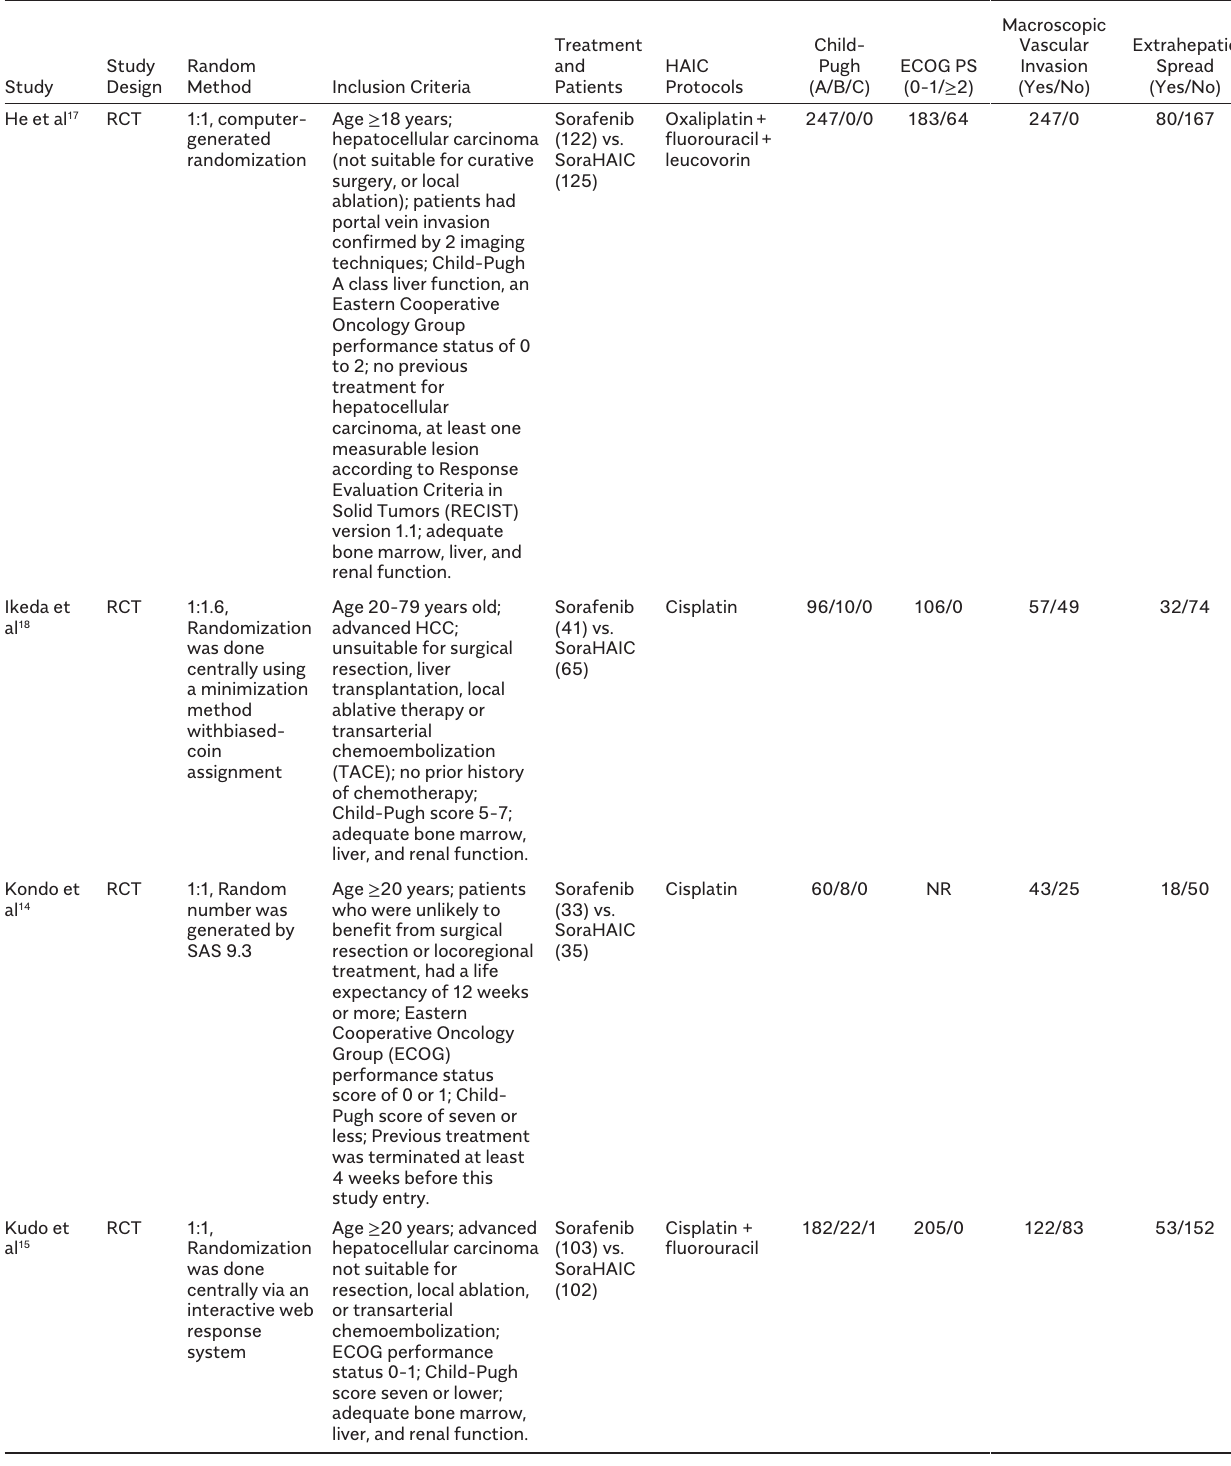
Table 1. Baseline Characteristics of Included Studies in the Meta-analysis